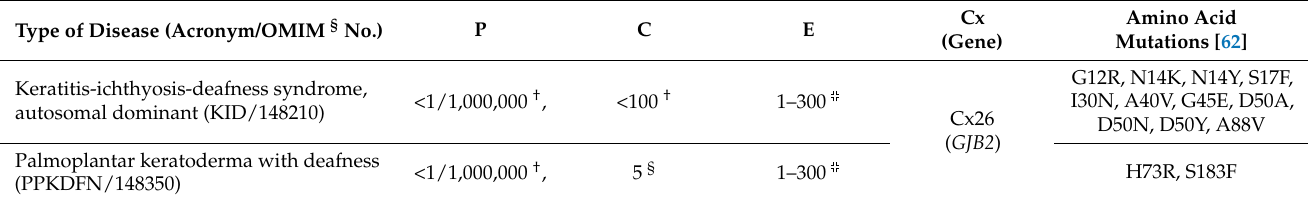
Table 1. Rare genodermatoses caused by leaky/hyperactive HCs. (P = prevalence; C = number of cases described in the literature; and E = estimated number of people with this